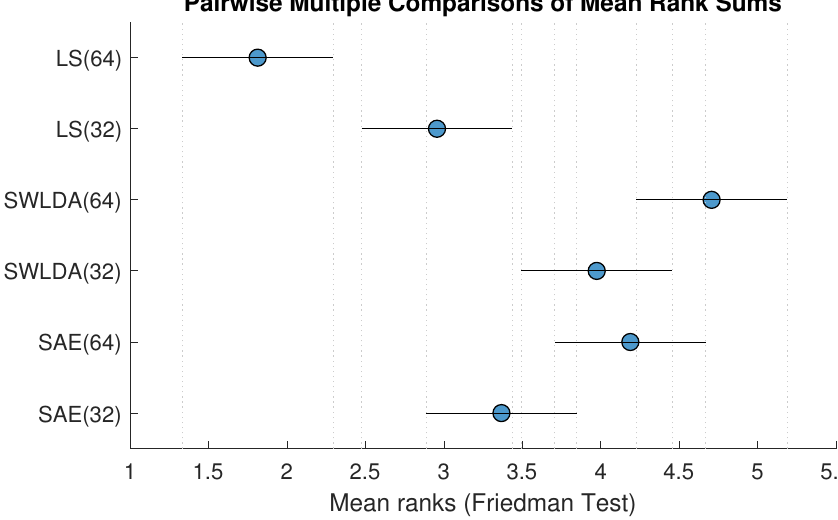
Figure 2. Post hoc analysis: Mean ranks of BCI accuracy with confidence intervals for each methods using multiple comparison method [32]. Higher numerical rank indicates better performance.